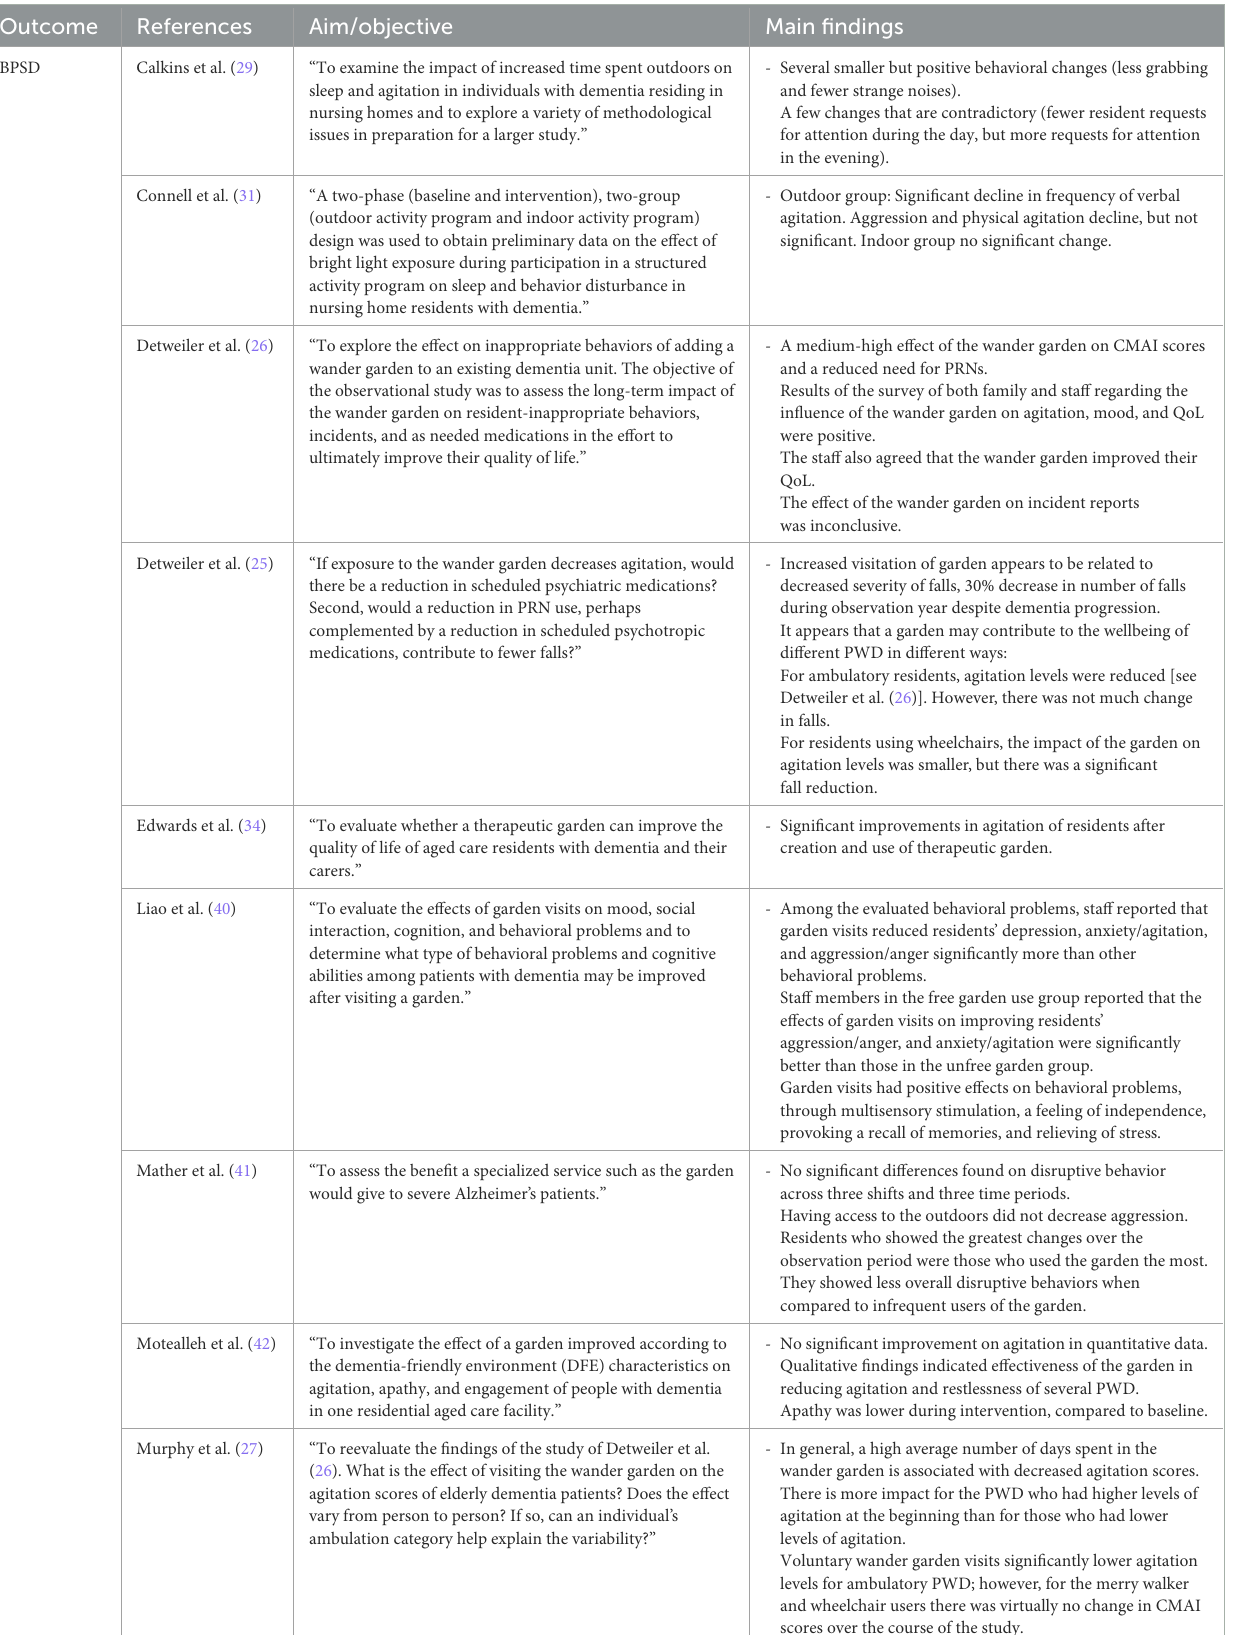
TABLE 3 Main findings on outcome measure BPSD ( n =